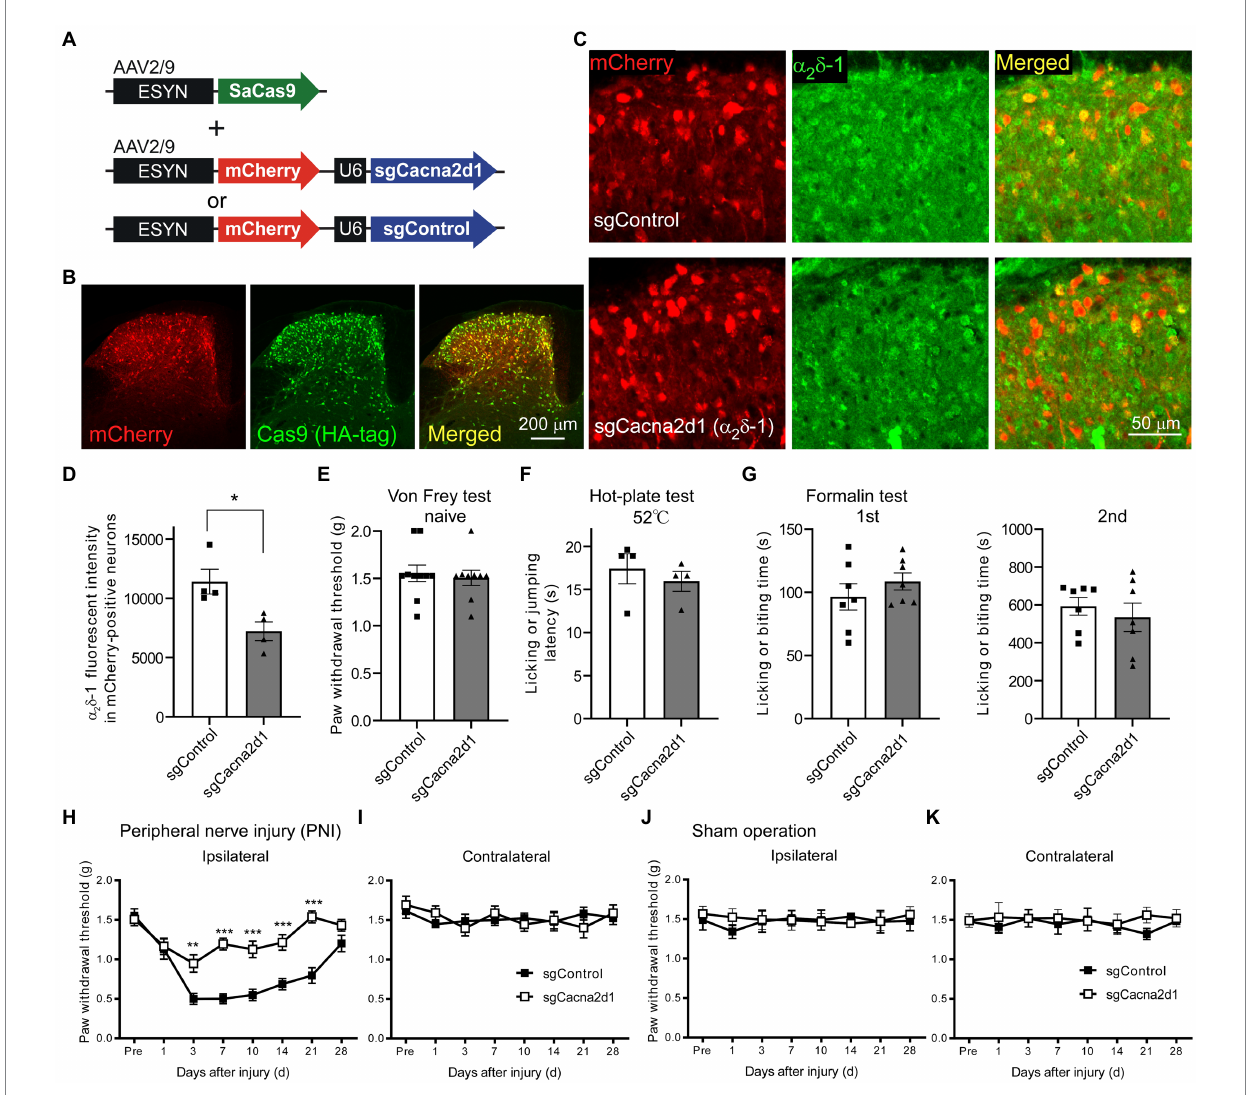
FIGURE 2 Mechanical hypersensitivity after PNI was ameliorated by AAV-CRISPR-Cas9-mediated α 2 δ -1 knockdown in SDH neurons. (A) Schematic of an AAV vector containing a neuronal SaCas9 expression cassette, and vectors containing the sgRNA targeting Cacna2d1 or control sgRNA fused with a neuronal mCherry expression cassette. (B) Representative images showing expression of mCherry (red) and SaCas9 (green) in the SDH. (C) Representative images showing α 2 δ -1 expression (green) in mice injected with the Cas9 expression vector and sgControl ( upper ) or sgCacna2d1 ( lower ) containing vector, respectively. (D) Summary of the α 2 δ -1 immunofluorescent intensity of mCherry-positive neurons in sgCacna2d1 and sgControl mice ( n = 4, 3 sections from 4 animals, and data are presented as mean ± SEM of averaged data from individual animals, two-tailed unpaired t -test, t = 3.12, df = 6, * p < 0.05). (E) Summary data of the paw withdrawal threshold of naïve mice [ n = 10 (sgControl), n = 9 (sgCacna2d1), two-tailed unpaired t -test, t = 0.391, df = 17, p = 0.701]. (F) Summary data of the latency for mice to lick their hindpaws or jump after being placed on a 52 ° C hot plate ( n = 4 each, two-tailed unpaired t -test, t = 0.692, df = 6, p = 0.515). (G) Summary of the duration for mice to lick their formalin-injected hindpaw for 0–5 min (first phase, left , n = 7 each, two-tailed unpaired t -test, t = 0.984, df = 12, p = 0.344) and for 10–60 min (second phase, right , n = 7 each, two-tailed unpaired t -test, t = 0.663, df = 12, p = 0.520) after formalin injection. (H) Paw withdrawal threshold ipsilateral to the injured side of sgControl or sgCacna2d1 mice before (pre) and after PNI. [ n = 10 (sgControl), n = 9 (sgCacna2d1), two-way repeated measurements ANOVA post-hoc Bonferroni’s test, Group, F (1,17) = 46.1, p < 0.0001, Time, F (7,119) = 20.2, p < 0.0001, Interaction F (7,119) = 5.91, p < 0.0001, ** p < 0.01, ***p < 0.001]. (I) Same as (H) but contralateral to the injured side [ n = 10 (sgControl), n = 9 (sgCacna2d1), two-way repeated measurements ANOVA post hoc Bonferroni’s test, Group, F (1,17) = 0.00552, p = 0.942, Time, F (7,119) = 1.07, p = 0.386, Interaction F (7,119) = 0.788, p = 0.599]. (J) Paw withdrawal threshold ipsilateral to the injured side of sgControl or sgCacna2d1 mice before (pre) and after sham operation [ n = 6 each, two-way repeated measurements ANOVA post-hoc Bonferroni’s test, Group, F (1,10) = 0205, p = 0.660, Time, F (7,70) = 0.155, p = 0.993, Interaction F (7,70) = 0.293, p = 0.955]. (K) Same as (J) but contralateral to the operated side [ n = 6 each, two-way repeated measurements ANOVA post-hoc Bonferroni’s test, Group, F (1,17) = 0.894, p = 0.367, Time, F (7,70) = 1.83, p = 0.988, Interaction F (7,70) = 0.356, p = 0.924]. Data are mean ±